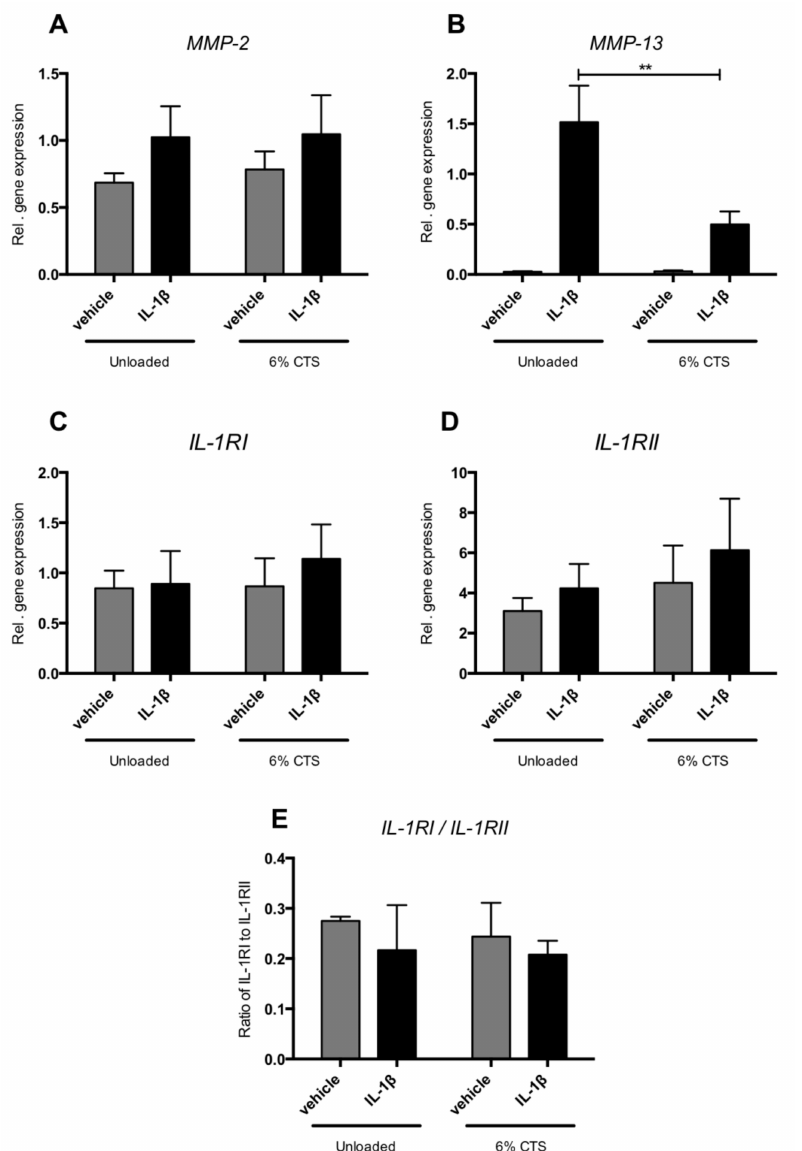
Figure 5. Mechanical strain reduces MMP-13 expression of condylar cells incubated with IL1- β . Gene expression of ( A ) MMP-13, ( B ) MMP-2, ( C ) IL1-RI, and ( D ) IL1-RII. ( E ) Ratio between IL-1RI and IL-1RII by condylar cells. Mechanical loading reduced IL-1 β -induced gene expression of MMP-13. ** Significant e ff ect of mechanical loading, p <